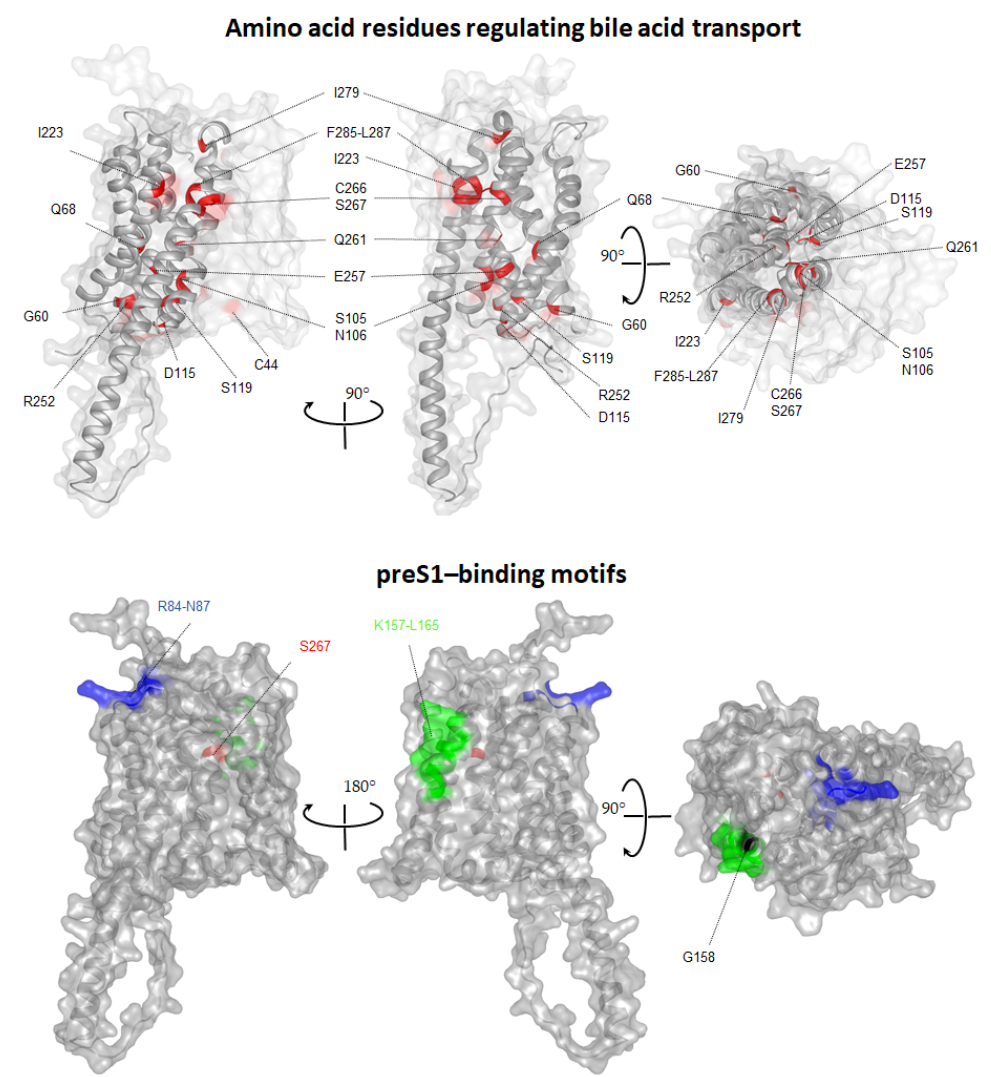
Figure 3. NTCP regions and amino acids essential for bile acid transport and HBV/HDV binding. The AlphaFold model of human NTCP (AF-Q14973-F1) was visualized with Protean 3D DNASTAR Software. (Top panel) To better visualize amino acids regulating bile acid transport, the NTCP “panel” domain (TMDs I, V and VI) was made transparent. Positions of core-localized amino acids, namely C44, G60, Q68, S105, N106, D115, S119, C170, I223, R252, E257, Q261, C266, S267, I279, F285, P286 and L287 are marked and colored in red. Two identical structures are related by a 90-degree rotation. (Lower panel) Transparent surface presentation of NTCP. Positions of amino acids involved in preS1-binding activity are labeled with colors ( 157 KGIVISLVL 165 (green), 158G (black), 84 RLKN 87 (blue), 267S (red)) (top panel) . Two identical structures are related by a 180 and 90-degree rotation.